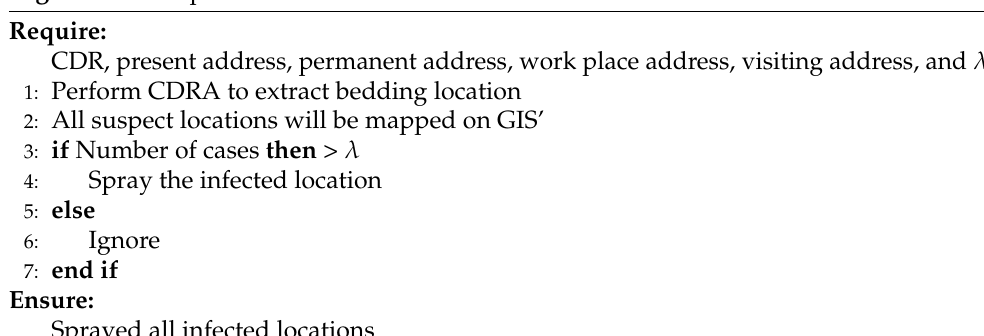
Algorithm 1 Proposed